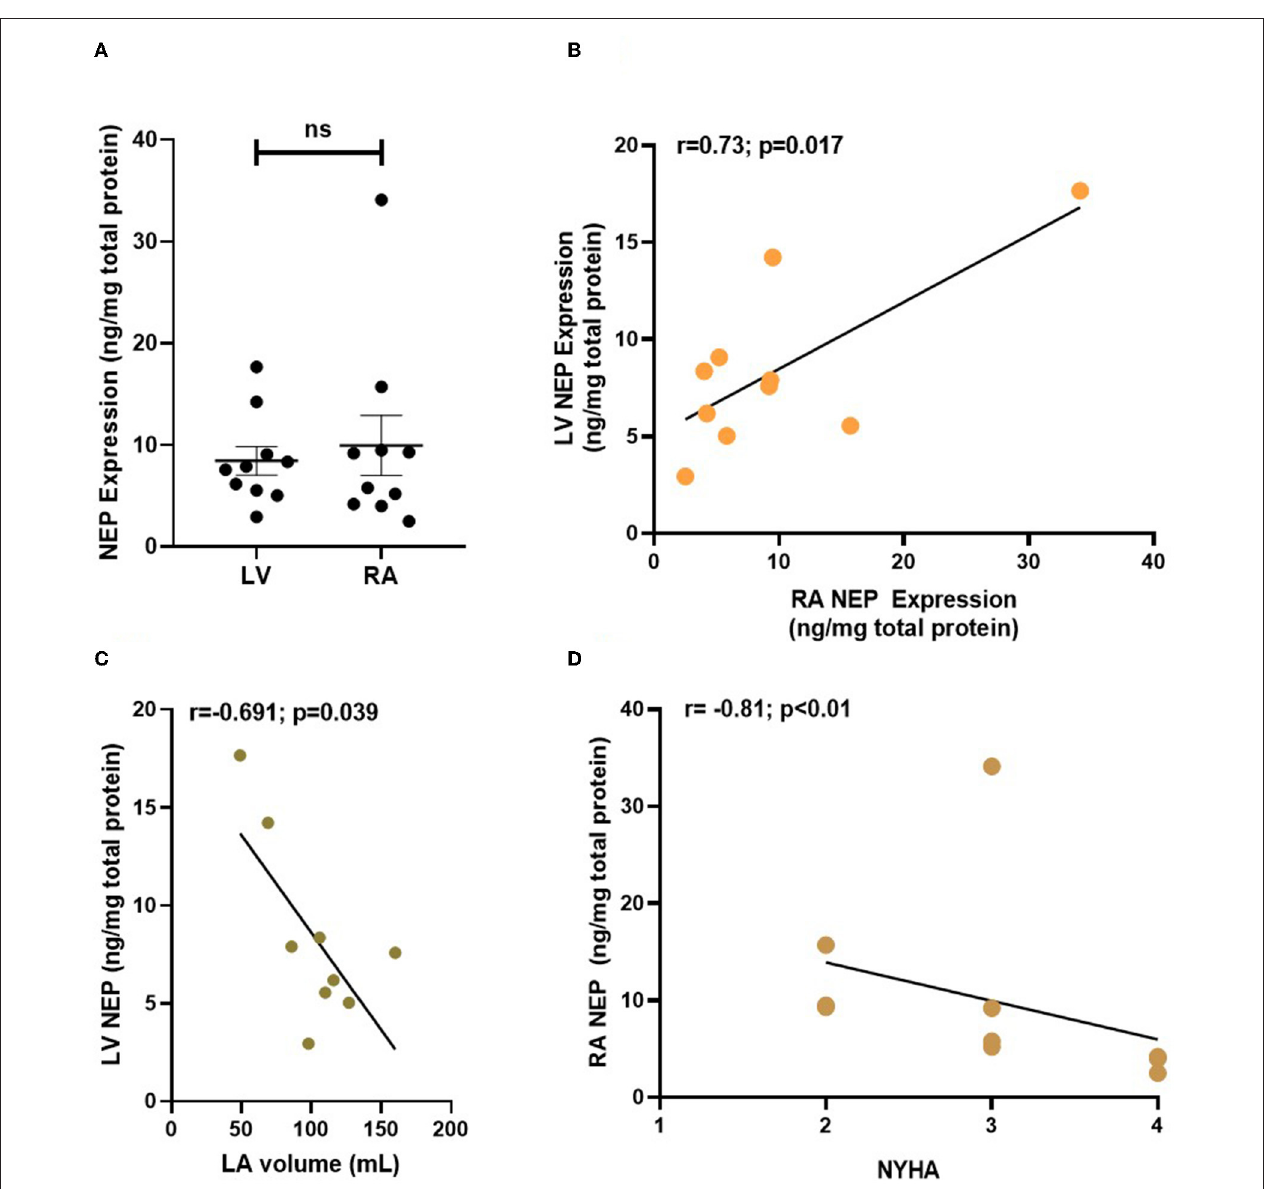
FIGURE 4 | NEP expression (in ng/mg of total protein) in human atrial and ventricular samples from patients with end-stage heart failure. NEP expression was analyzed in RA and LV biopsies from n = 10 patients with end-stage heart failure. NEP is equally expressed in the failing atrial and ventricular myocardium (A) and expression of atrial and ventricular NEP correlates in the patient cohort (B) . LV NEP expression correlates inversely with LA volume (C) and RA NEP negatively correlates with patient NYHA (D) . Each point represents data from one patient. NEP, Neprilysin; LV, left ventricle; LA, left atrium; RA, right